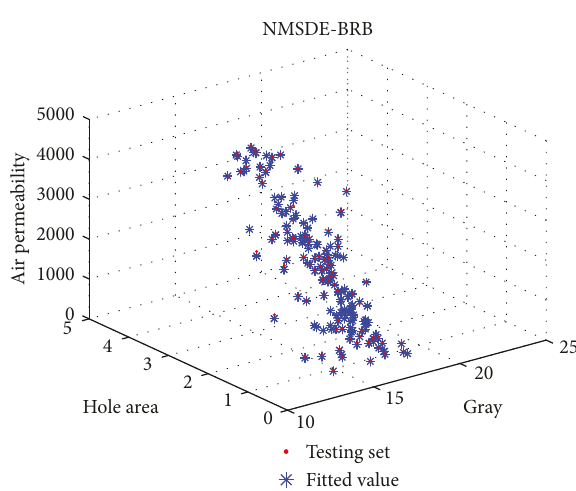
Figure 6: The testing samples and output MNMSDE-BRB.